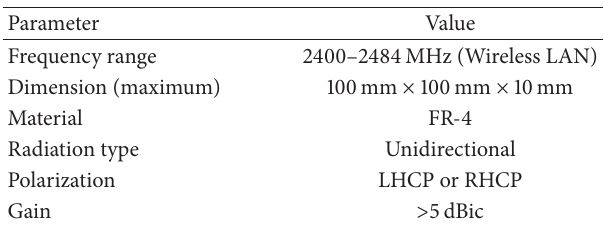
Table 2: The antenna